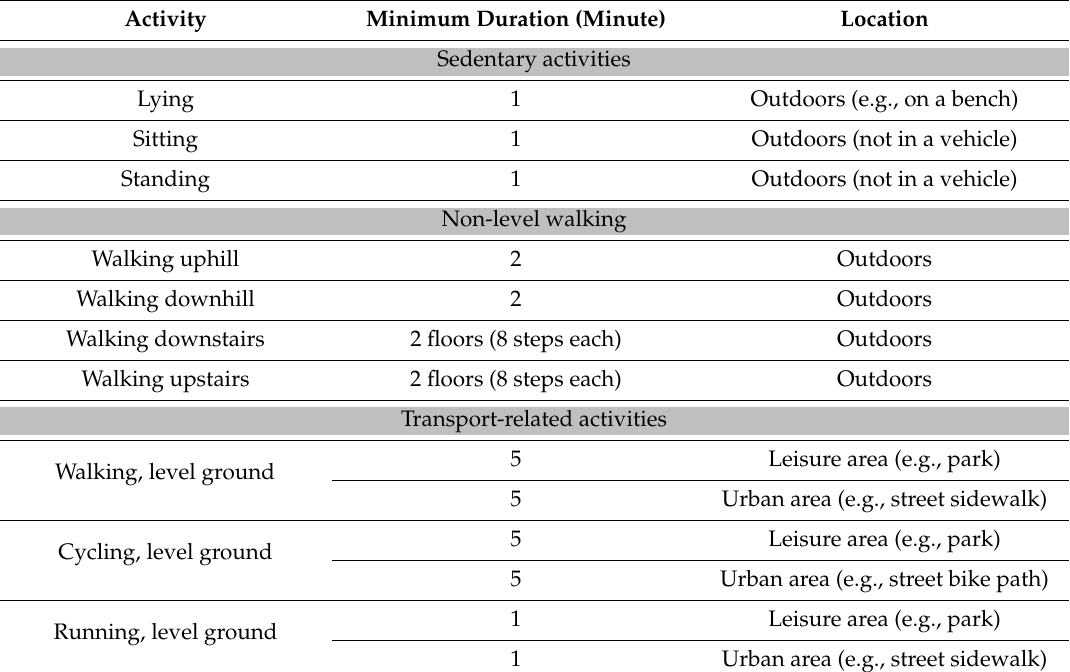
Table A2. Activity tasks for the real-life data